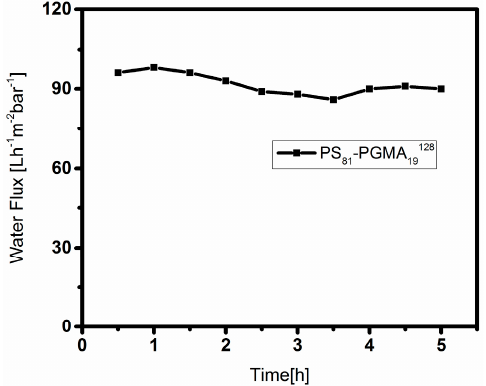
Figure 12. Time-dependent water flux measurements of membrane (previously shown in Figure 9b).